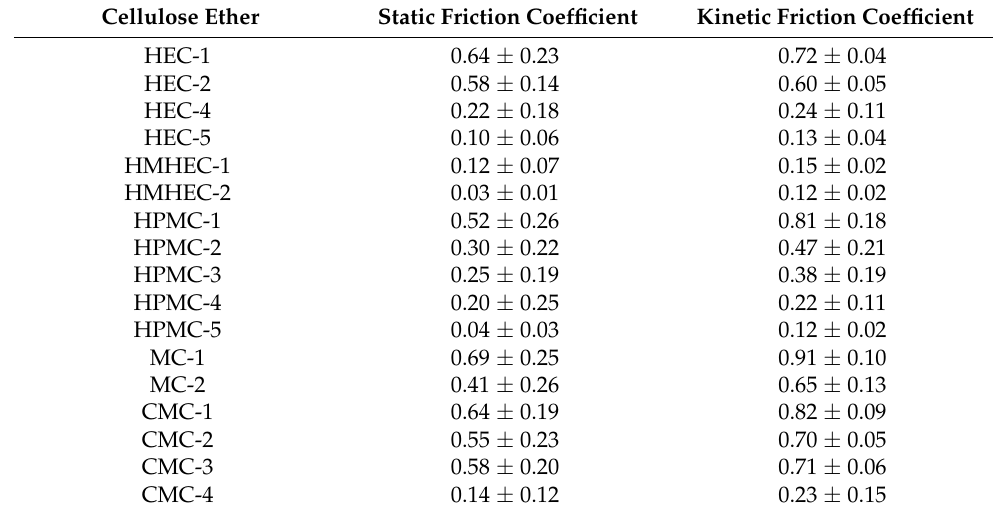
Table 4. Static and kinetic friction coefficient data of cellulose